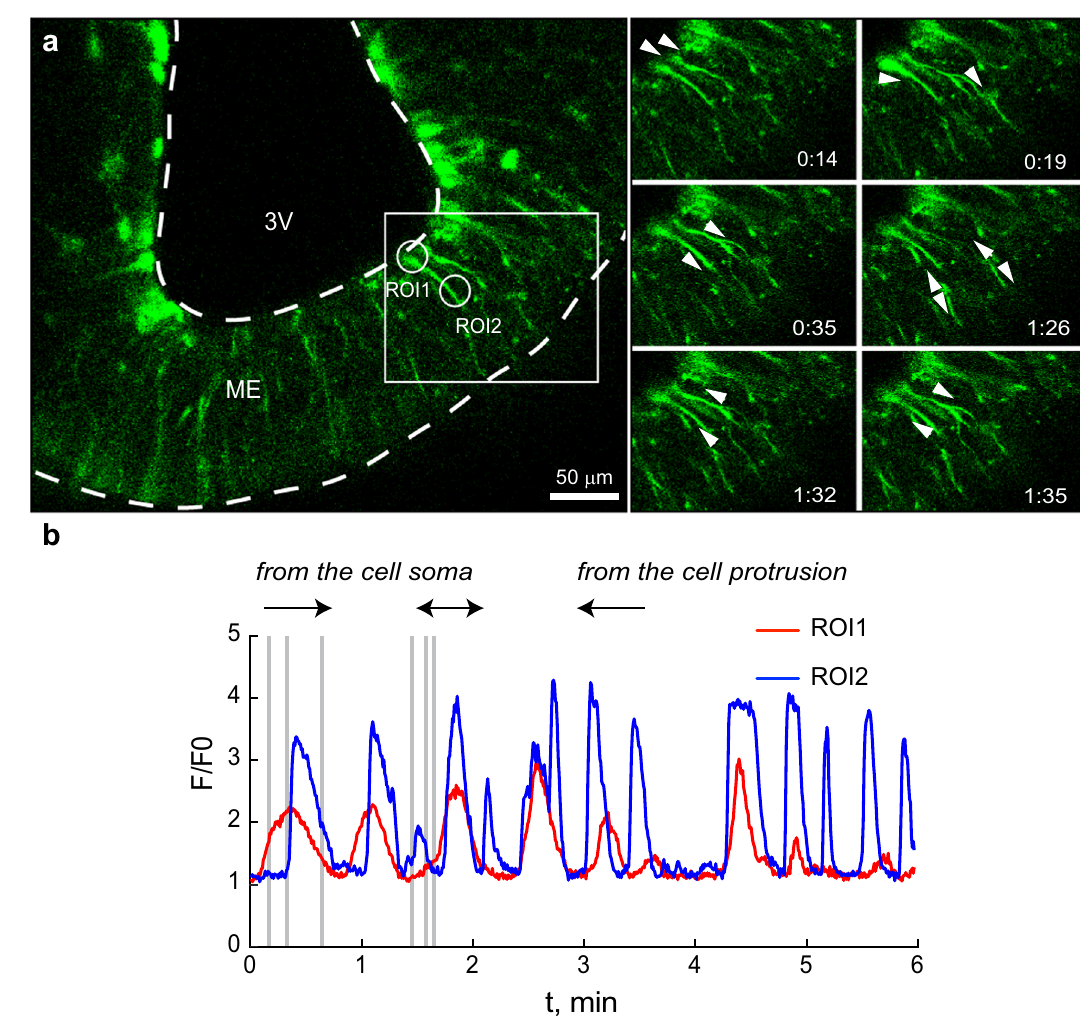
Fig. 2 | Bidirectional propagation of calcium transients within M5 tanycytes. a Images of a representative coronal section of the median eminence (ME) from a M5-GCaMP mouse showing spontaneous activity. Tanycytic cell bodies protrude fromthethirdventricle(3V)walltotheexternalzoneof theME.Time frameseries of the marked area ( a , white rectangle) shows the propagation of the waves (see white arrows). b Normalized intensities of the GCaMP3 fl uorescence from the cell bodyandtheprocess(redtraceandbluetraceforROI1andROI2ina,respectively)